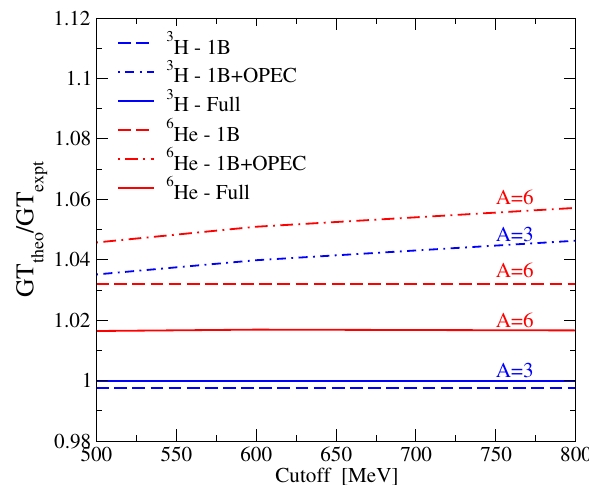
Fig. 8. Relative contributions to the theoretical GT matrix ele- ments as a function of the EFT cuto ff . All the results are normal- ized to the empirical values. The blue lines indicated by A = 3 correspond to the 3 H- 3 He β -decay. The red lines indicated by A = 6 correspond to the 6 He- 6 Li case. Dashed lines correspond to the 1-body impulse approximation (1B). Dashed-dotted lines cor- respond to 1-body plus one-pion exchange current (OPEC). Con- tinuous lines correspond to full calculation (note that in the case of 3 H this is calibrated to give exactly the experimental value). Figure taken from